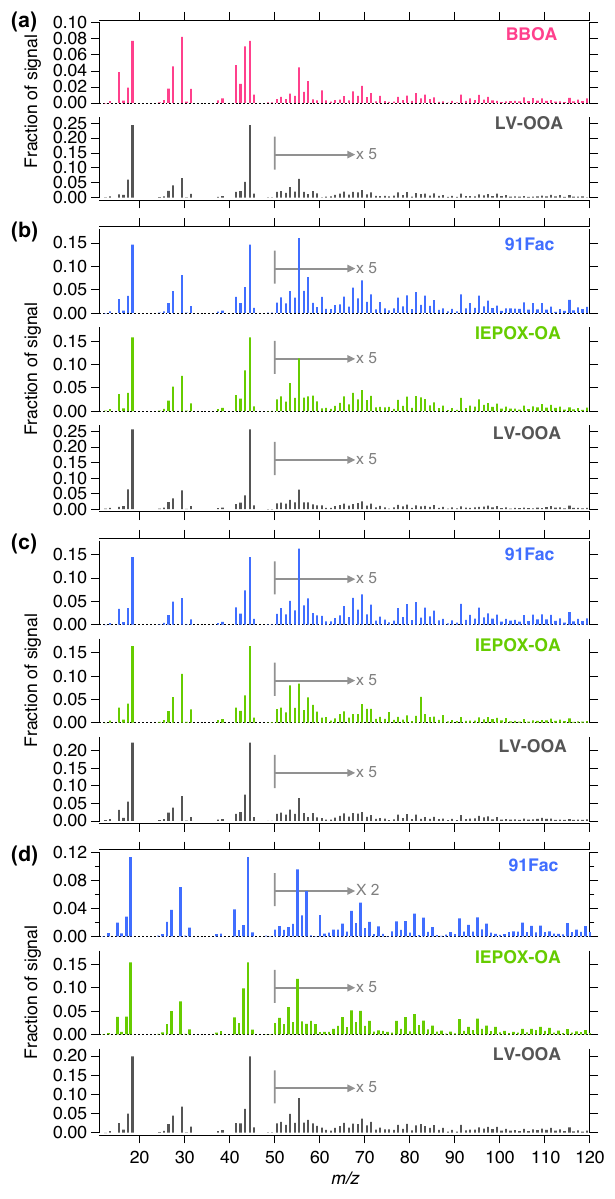
Figure 6. Mass spectra of PMF factors resolved from (a) winter, (b) spring, (c) summer and (d) fall OA measured at LRK in 2013.